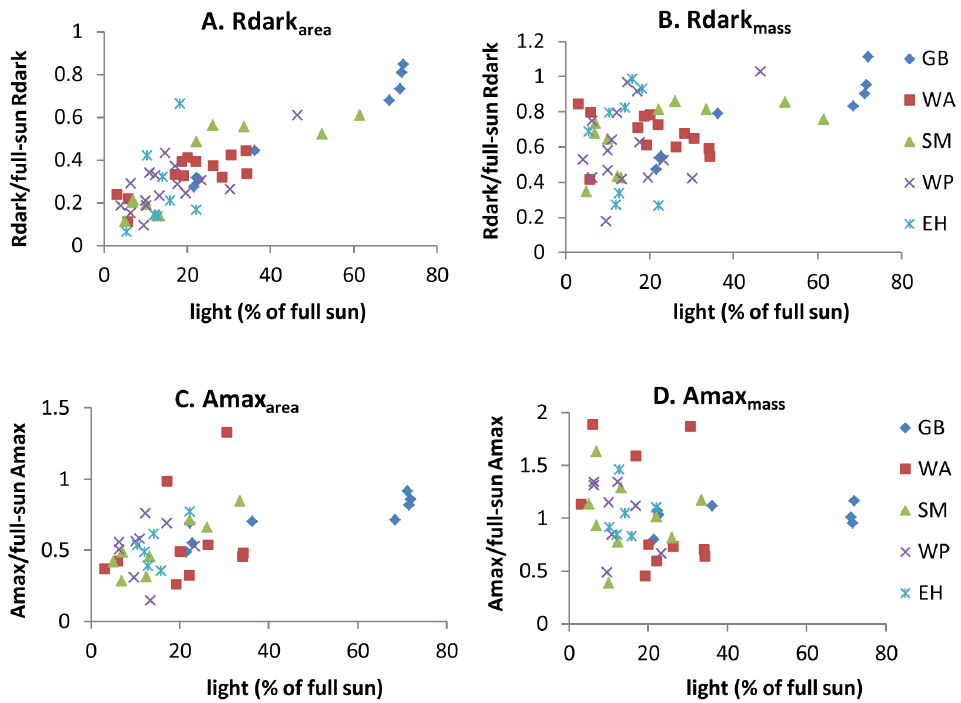
Figure 3. Relationship between normalized Amax or Rdark (measured value divided by species mean full-sun value) and light. Species code: GB=gray birch, WA=white ash, SM=sugar maple, WP=white pine, EH=eastern hemlock.